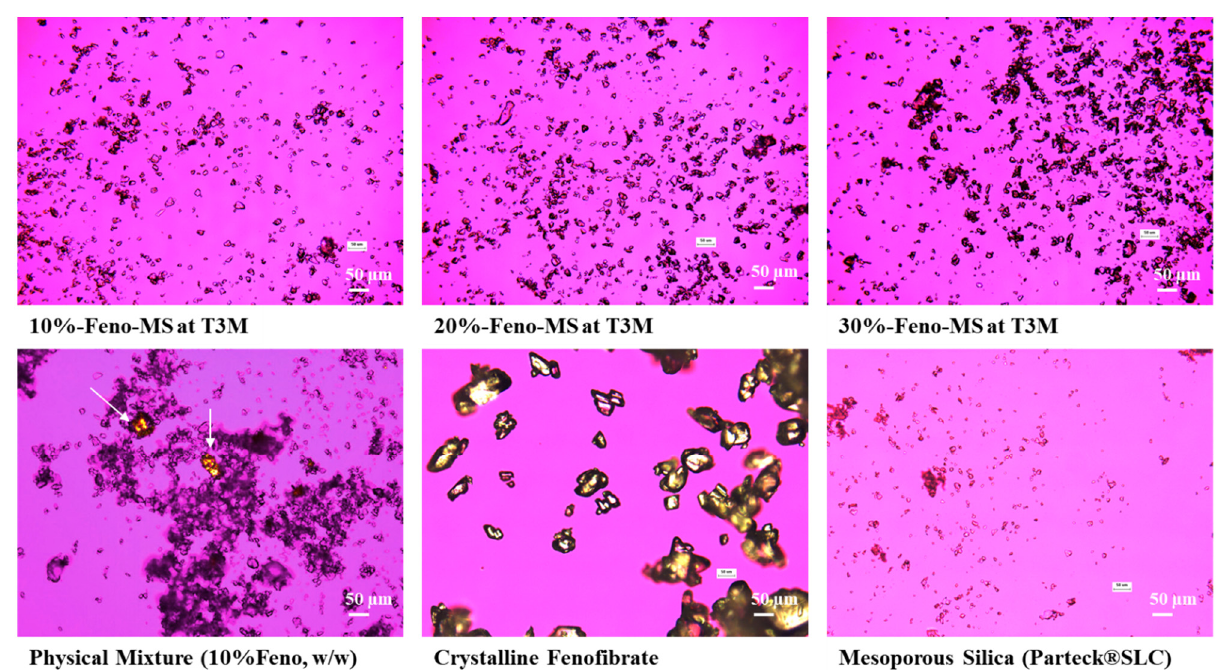
Figure 5. PLM images of Feno-MS samples (10%, 20%, and 30% drug load at T3M under accelerated conditions of 40 °C/75% RH in open dish), the physical mixture of crystalline fenofibrate and mesoporous silica at a weight ratio of 10:90 ( w / w ), pure crystalline fenofibrate, and mesoporous silica (Parteck ® SLC). Magnification × 100.